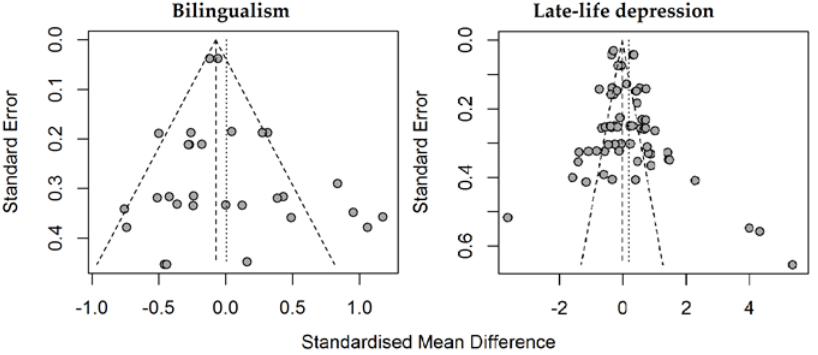
Figure 4. Funnel plots for studies on late-life depression ( left ) and bilingualism ( right ). An asymmetrical distribution suggests publication bias.